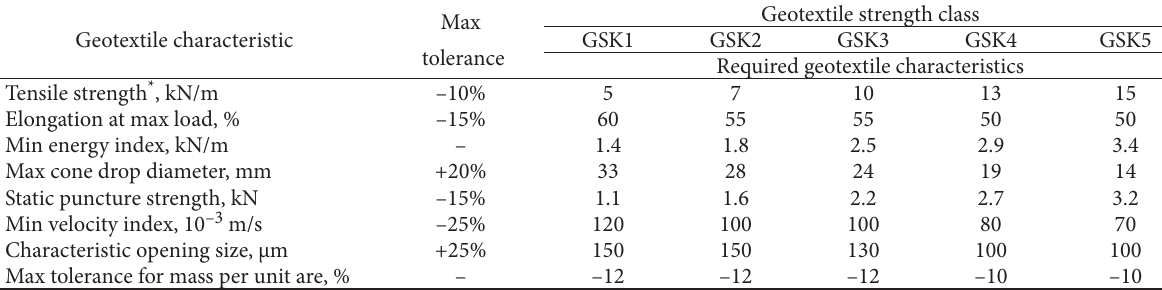
Table 4. Required values for the geotextile properties on the basis of geotextile strength classes Geotextile